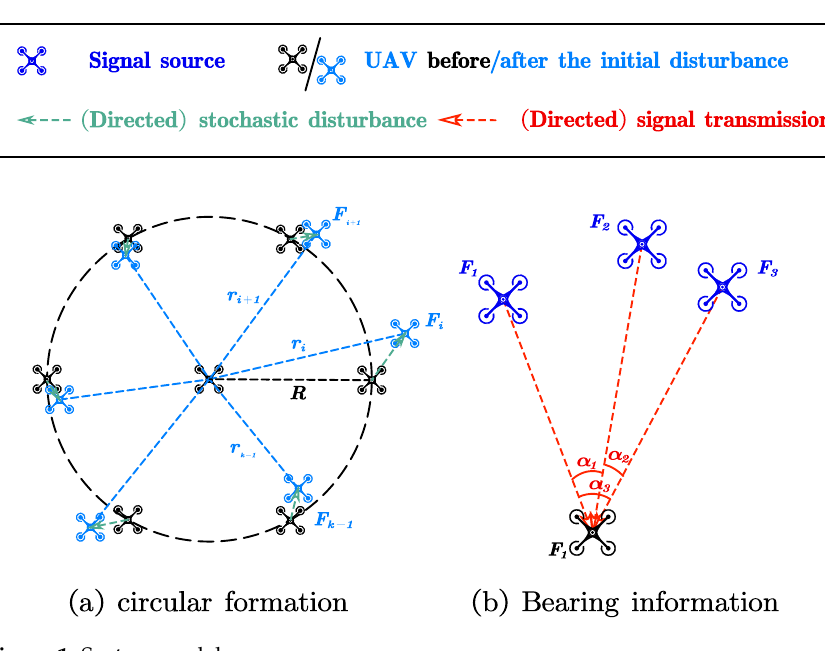
Figure 1. System